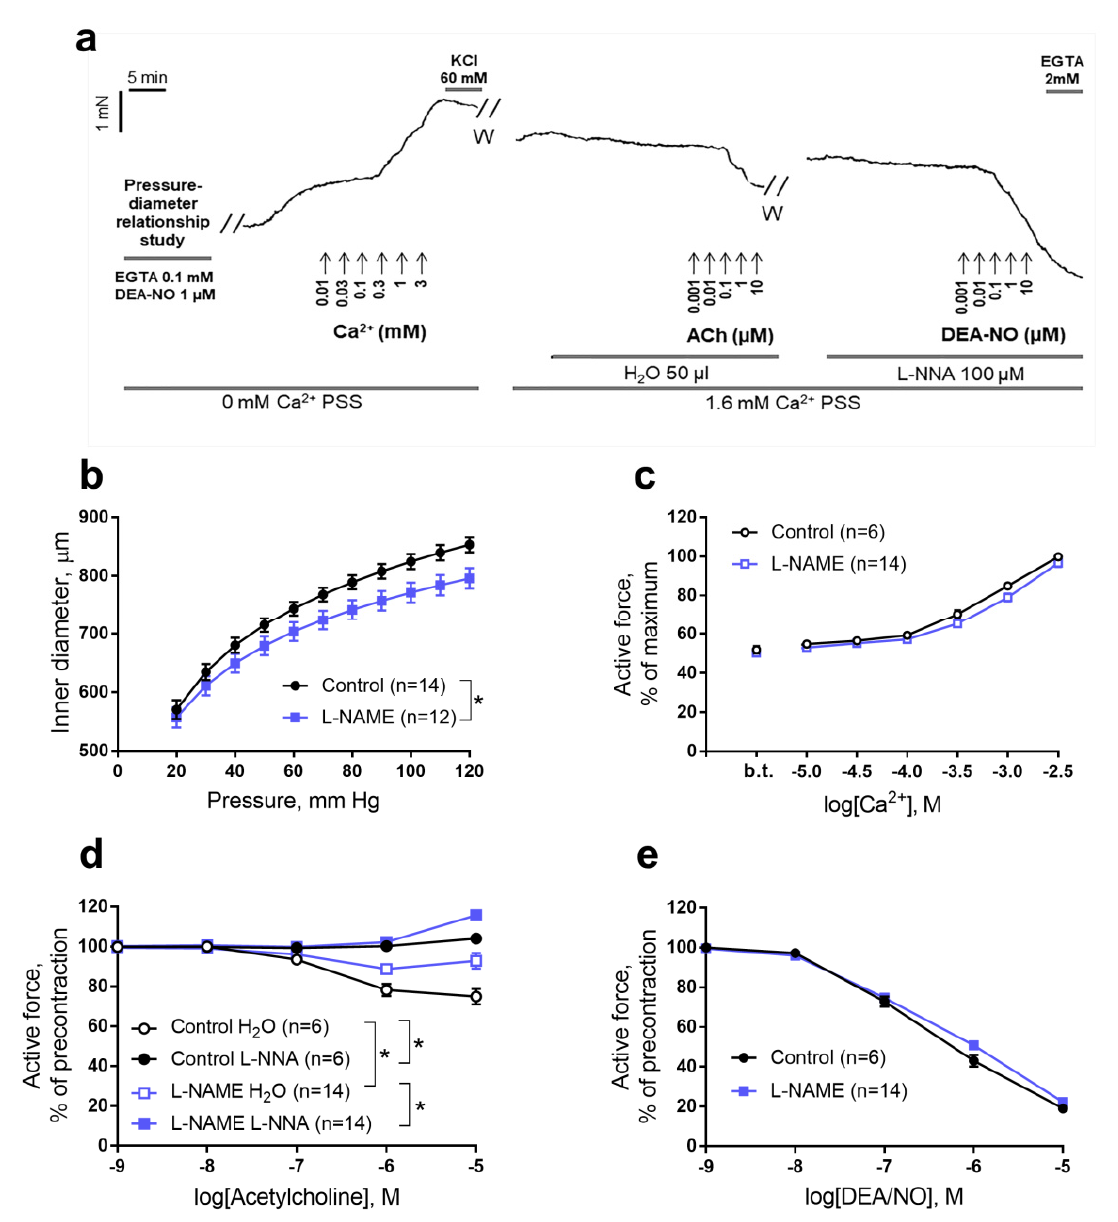
Figure 2. Functional studies of aortic segments of 1–2-day-old rat pups born to control and L-NAME-treated females. ( a ) Representative recording of the experiment on the aortic segment from the “Control H 2 O” group. ( b ) Passive transmural pressure-inner diameter relationships. ( c ) Aortic contractile responses to a stepwise increase of extracellular Ca2+ concentration. ( d ) The responses to acetylcholine in the presence of solvent (H2O) or NO-synthase inhibitor L-NNA (100 µ M). ( e ) The responses to NO-donor DEA/NO in the presence of 100 µ M NO-synthase inhibitor L-NNA. B.t.—basal tone; n —number of rat pups. Data are presented as mean and S.E.M. * p < 0.05 (Repeated Measures ANOVA). ACh—acetylcholine, PSS—physiological salt solution,